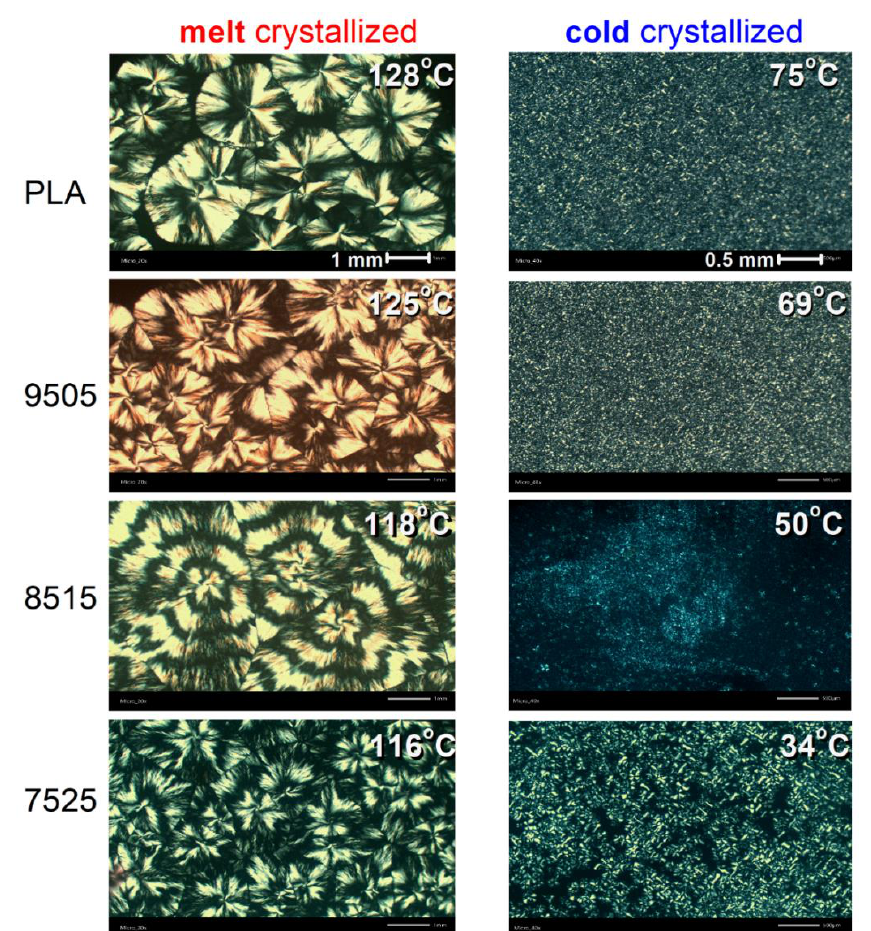
Figure 6. PLM micrographs for all the PLA-based samples suffered ( left ) melt- and ( right ) cold- isothermal crystallization, at the marked temperatures. The shown images correspond to the final states of crystallization. The added scale bars at the top -left and -right images correspond to all PLM images, i.e., 1 mm for the left-side and 0.5 mm for the right side.